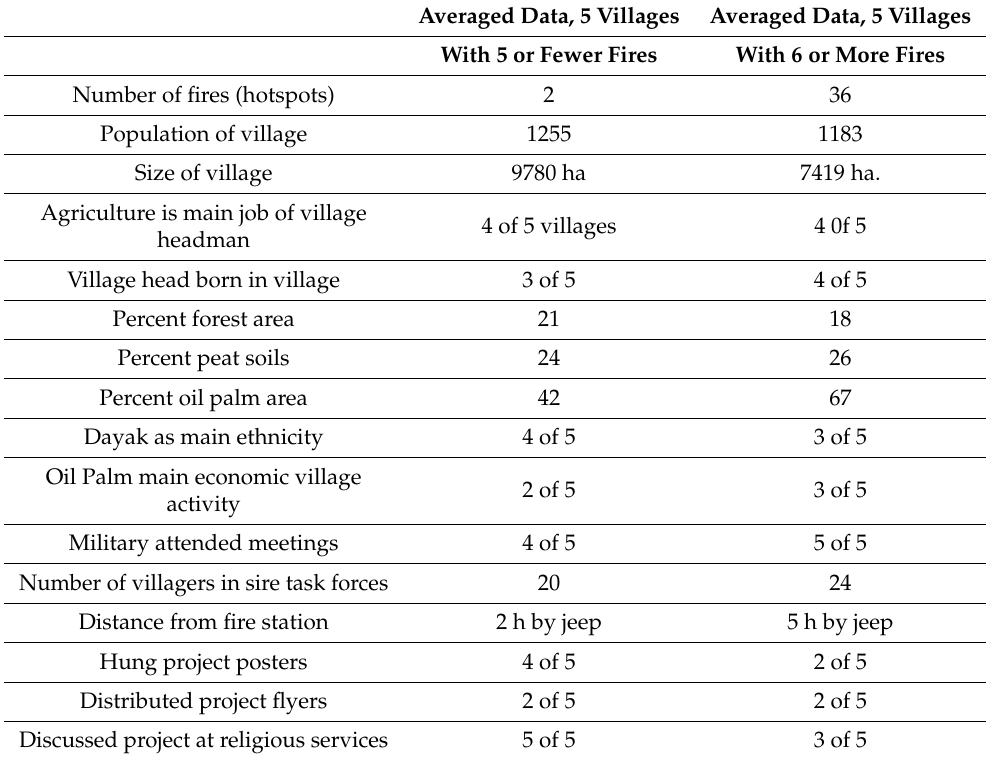
Table A1. Comparative Data from a 10-Village Survey in West Kalimantan,